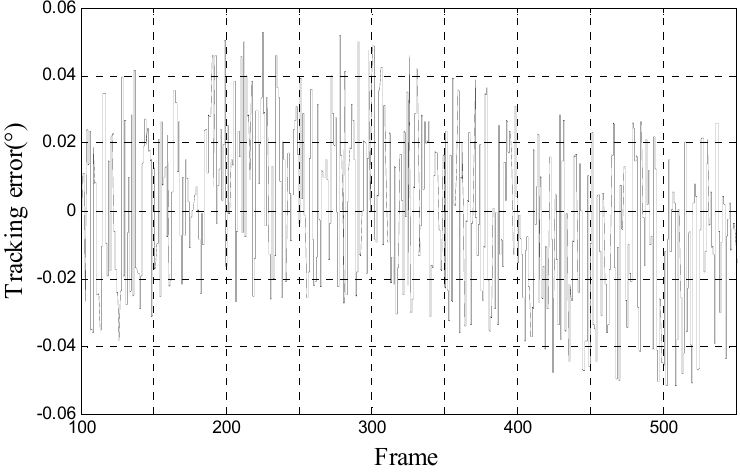
Figure 11. Tracking error of proposed method when moving-target move with 10° 0.1 Hz .